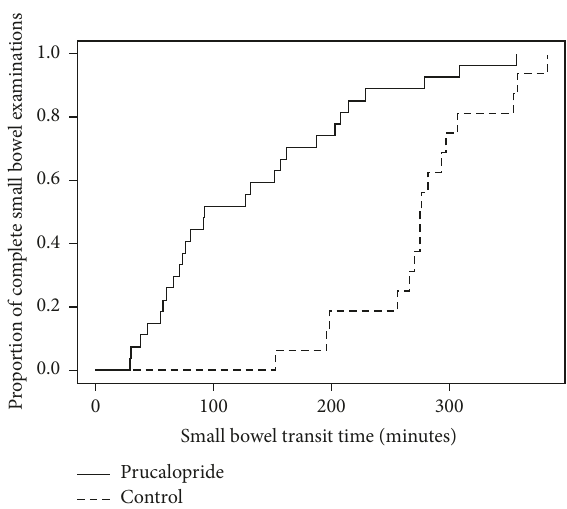
Figure 1: Kaplan-Meier curves for time to complete small bowel examination since the first duodenal image for all VCE that reached cecum. The median SBTT was significantly shorter in the prucalopride group (92, 95% CI: 74, 187) compared to the control group(275.5,95%CI:266,354). VCE,videocapsuleendoscopy;SBTT, small bowel transit time; CI, confidence interval.